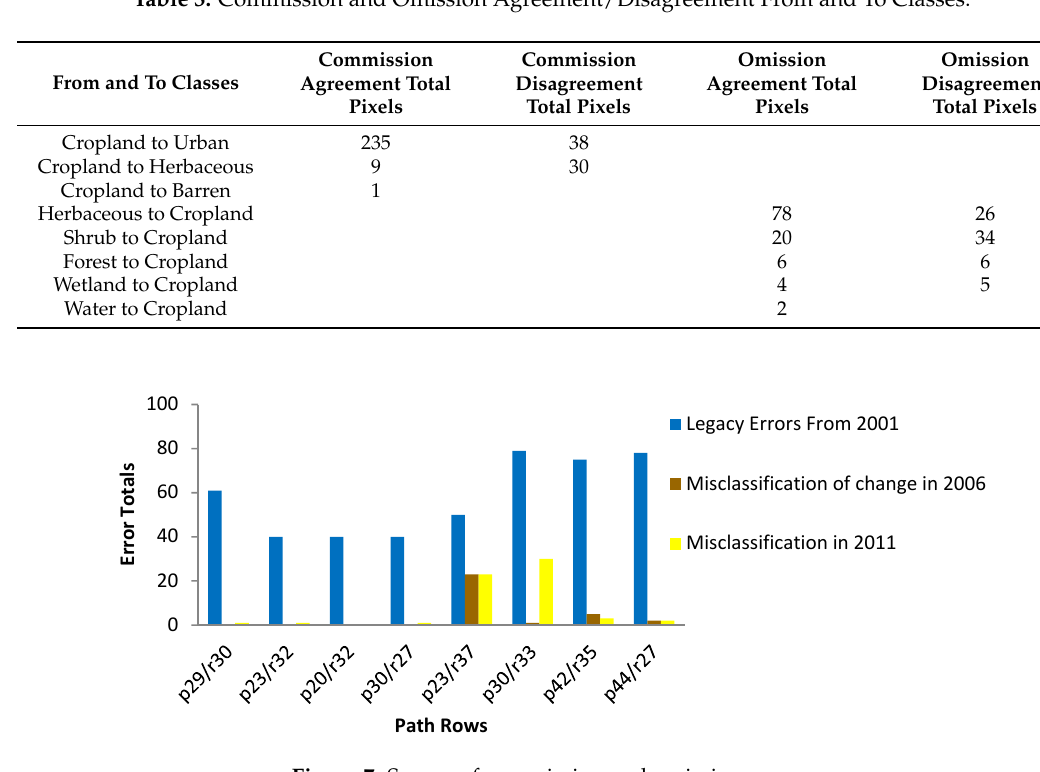
Figure 7. Source of commission and omission errors.